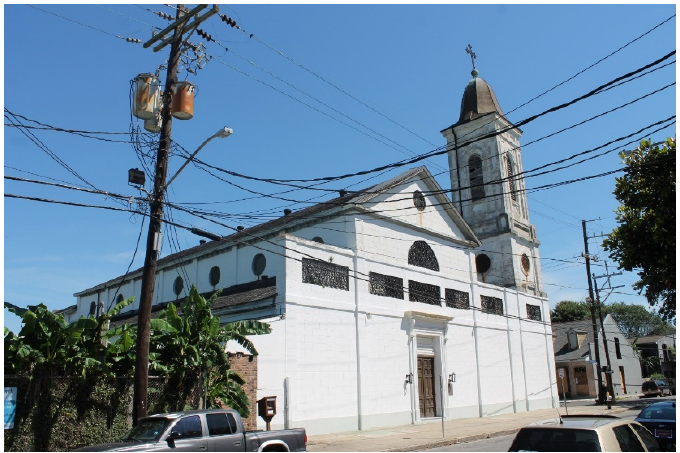
Figure 3. Saint Augustine Catholic Church, Treme Community, New Orleans, Louisiana, 2017. Image by the author. June 2017.